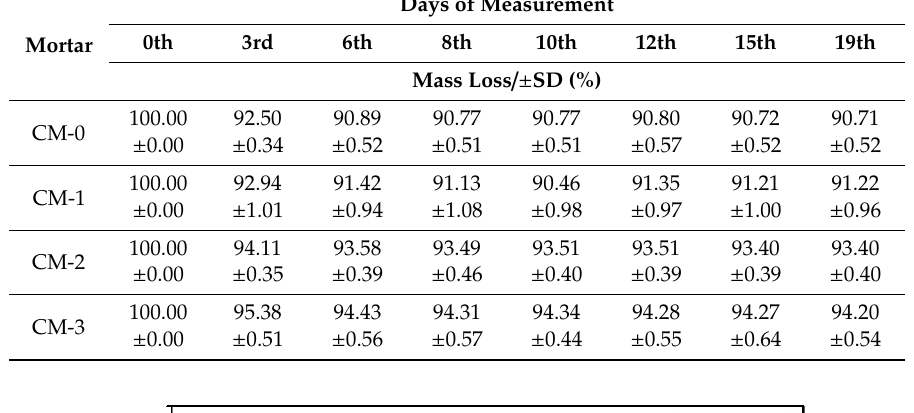
Table 5. The average values of the mass loss of the samples over time and the standard deviation.